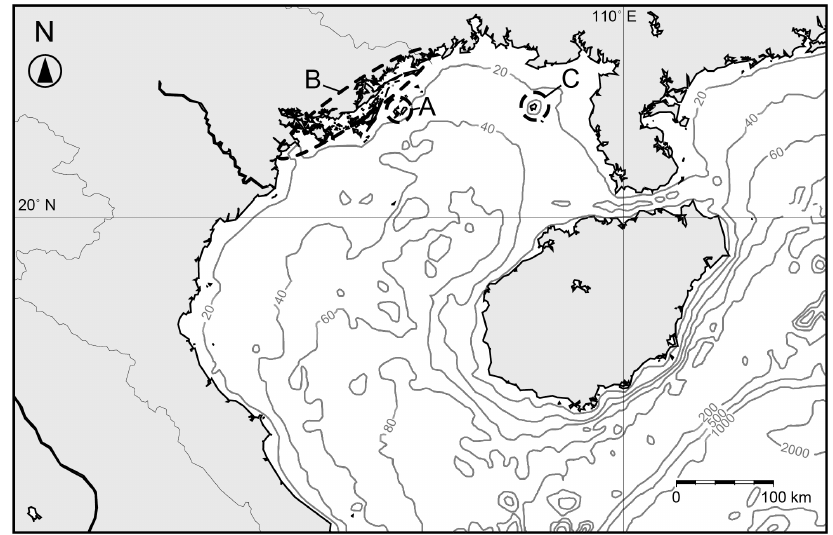
Figure 5. Map of the Gulf of Tongking with isobaths plotted. Labels A–C are the sites of studies of ostracod assemblages: A: The Co To Islands (this study); B: northeastern coast of Vietnam (Tanaka et al., 2009); C: Weizhou Island (Ruan,